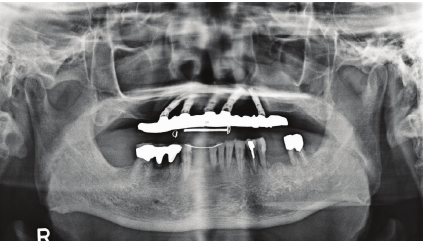
Figure 4: The initial panoramic radiograph revealed severe bone loss around R3 and L2